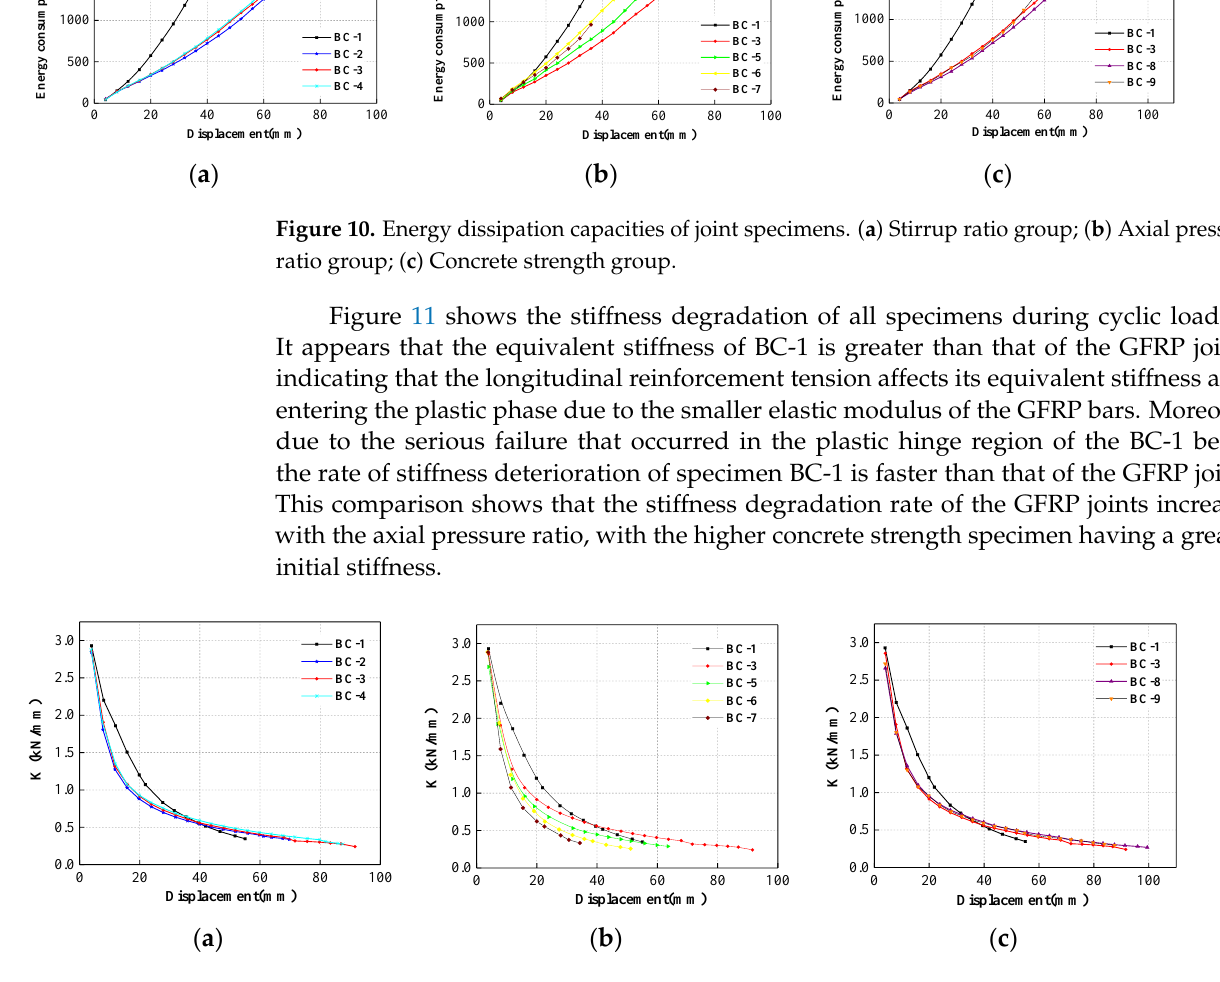
( c ) Figure 12. Maximum strains of longitudinal reinforcement. ( a ) Stirrup ratio group; ( b ) Axial pres- sure ratio group; ( c ) Concrete strength group. In addition, Figure 13 shows the maximum strains of the GFRP hoops in the core area. As expected, the maximum strain in the RC joint specimen is significantly greater than those in the GFRP joint specimens, indicating that there are greater shear forces oc- curring in the core area of the RC joint due to the high stiffness of the longitudinal steel beam reinforcement. Comparing the GFRP joints with different variables, the maximum strains of the GFRP hoops increase with the stirrup ratio and decrease with the axial pres- sure ratio, and the maximum utilization rate captured in the joint stirrups exceeds 11.9% (BC-4). The GFRP hoop strains did not exceed their ultimate strains in the end. In conjunc- tion with the final damage of the specimens, no significant damage occurs in the concrete in the core of the joint specimens, indicating that the reinforcement scheme of GFRP hoops in the core is appropriate for the joint.